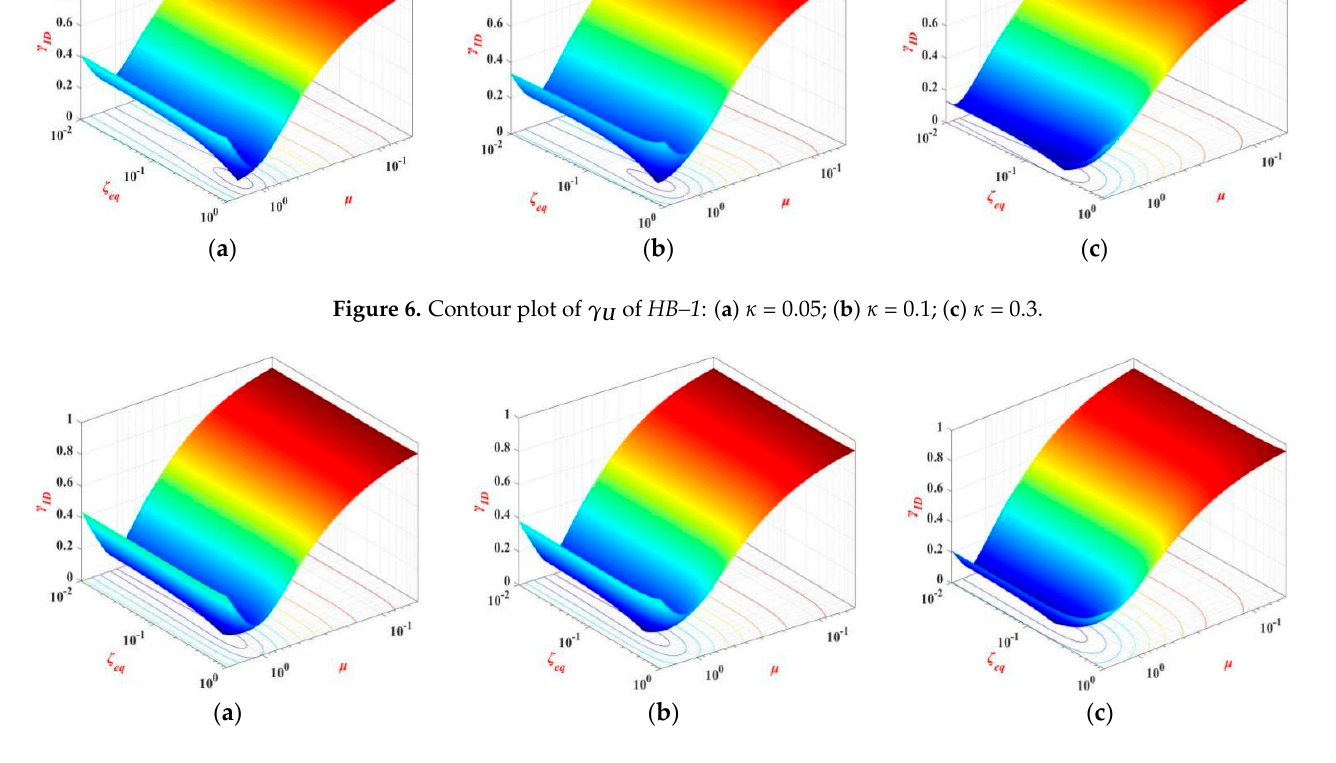
Figure 7. Contour plot of γ U of HB–2 : ( a ) κ = 0.05; ( b ) κ = 0.1; ( c ) κ = 0.3.